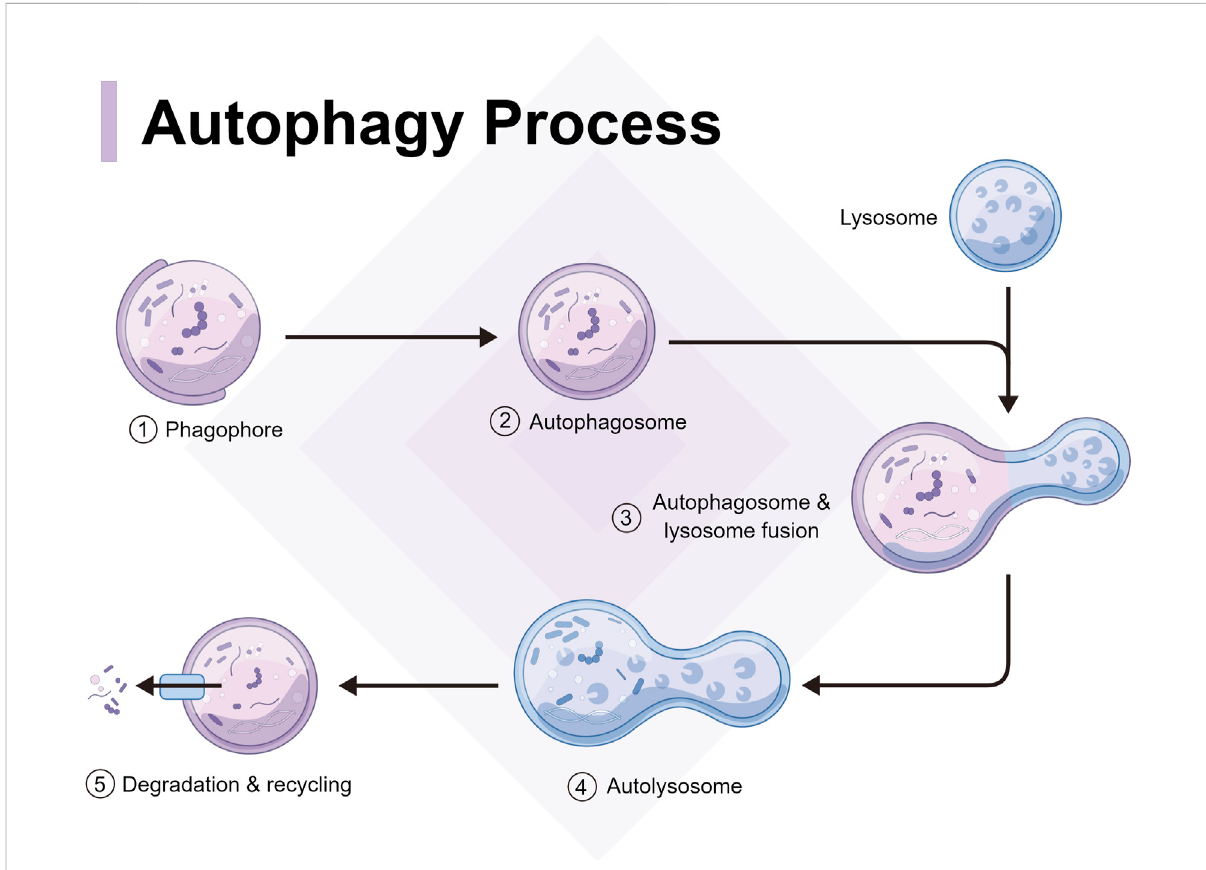
FIGURE 1 Process and mechanism of autophagy, including autophagy signal induction, precursor formation, phagocytic vesicle extension, autophagosome and lysosome fusion, and autophagolysosome